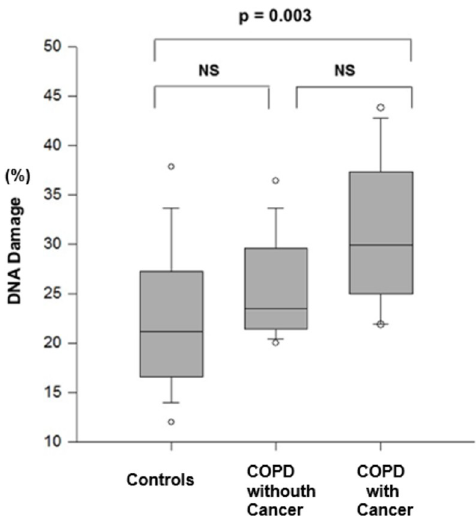
times greater in smokers than in non-smokers, plays a role in the initiation of the tumorigene- sis process and inactivation of defence mechanisms, such as low levels of antioxidants [13, 14]. MDA levels showed a positive association with the interaction between COPD and cancer, which indicates high levels of oxidative stress in these patients, capable of promoting DNA damage. MDA is a by-product of lipid peroxidation and is evaluated as a biomarker of oxida- tive stress in several pulmonary diseases, including COPD [30]. While there are few studies involving this biomarker, there is one study that suggests that patients with COPD presented higher levels of MDA in the exhaled breath condensate than the control group of smokers